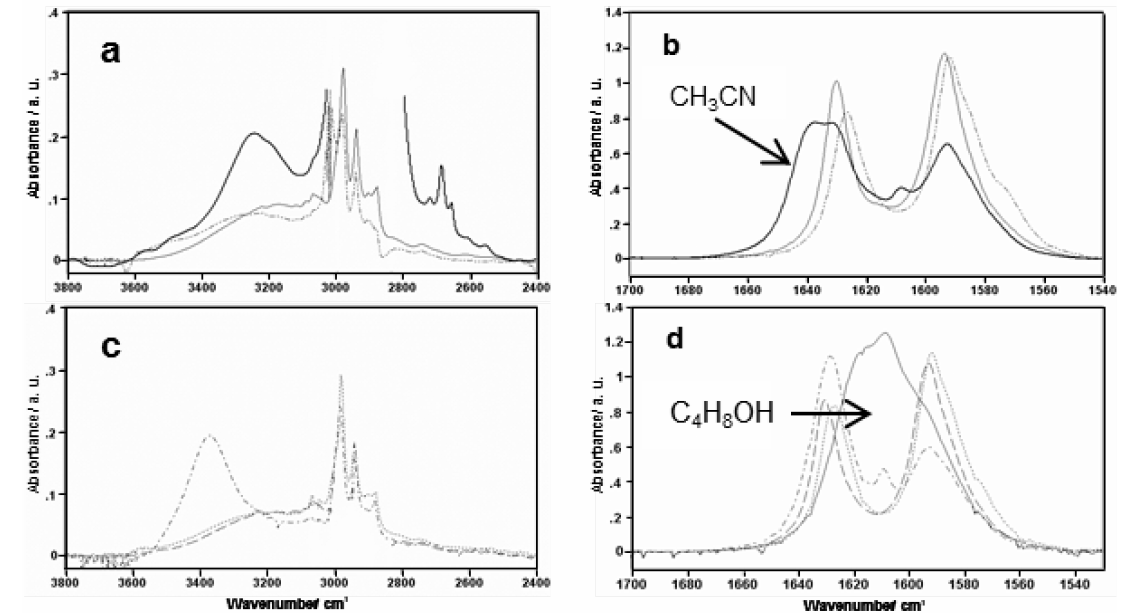
Figure 15. Infrared spectra of 2-hydroxy- N , N -diethylbenzamide ( 3 , R 1 = R 2 = C 2 H 5 ; Figure 1) in the region of the ν (OH) (left side) and ν (C=O) (right side) modes for 2-hydroxy- N , N -diethylbenzamide: ( a , b ) solid line—CCl 4 , .. line—CHCl 3 , bold line—C 4 H 8 O; ( c ) - - - line—C 4 H 9 Cl, .. line—CH 2 Cl 2 , -.-.- line —CH 3 CN; ( d ) - - - line—C 4 H 9 Cl, .. line—CH 2 Cl 2 , -.-.- line—CH 3 CN, solid line—C 4 H 9 OH. Reprinted with permission from [94]. Copyright 2008 John Wiley & Sons, Ltd.